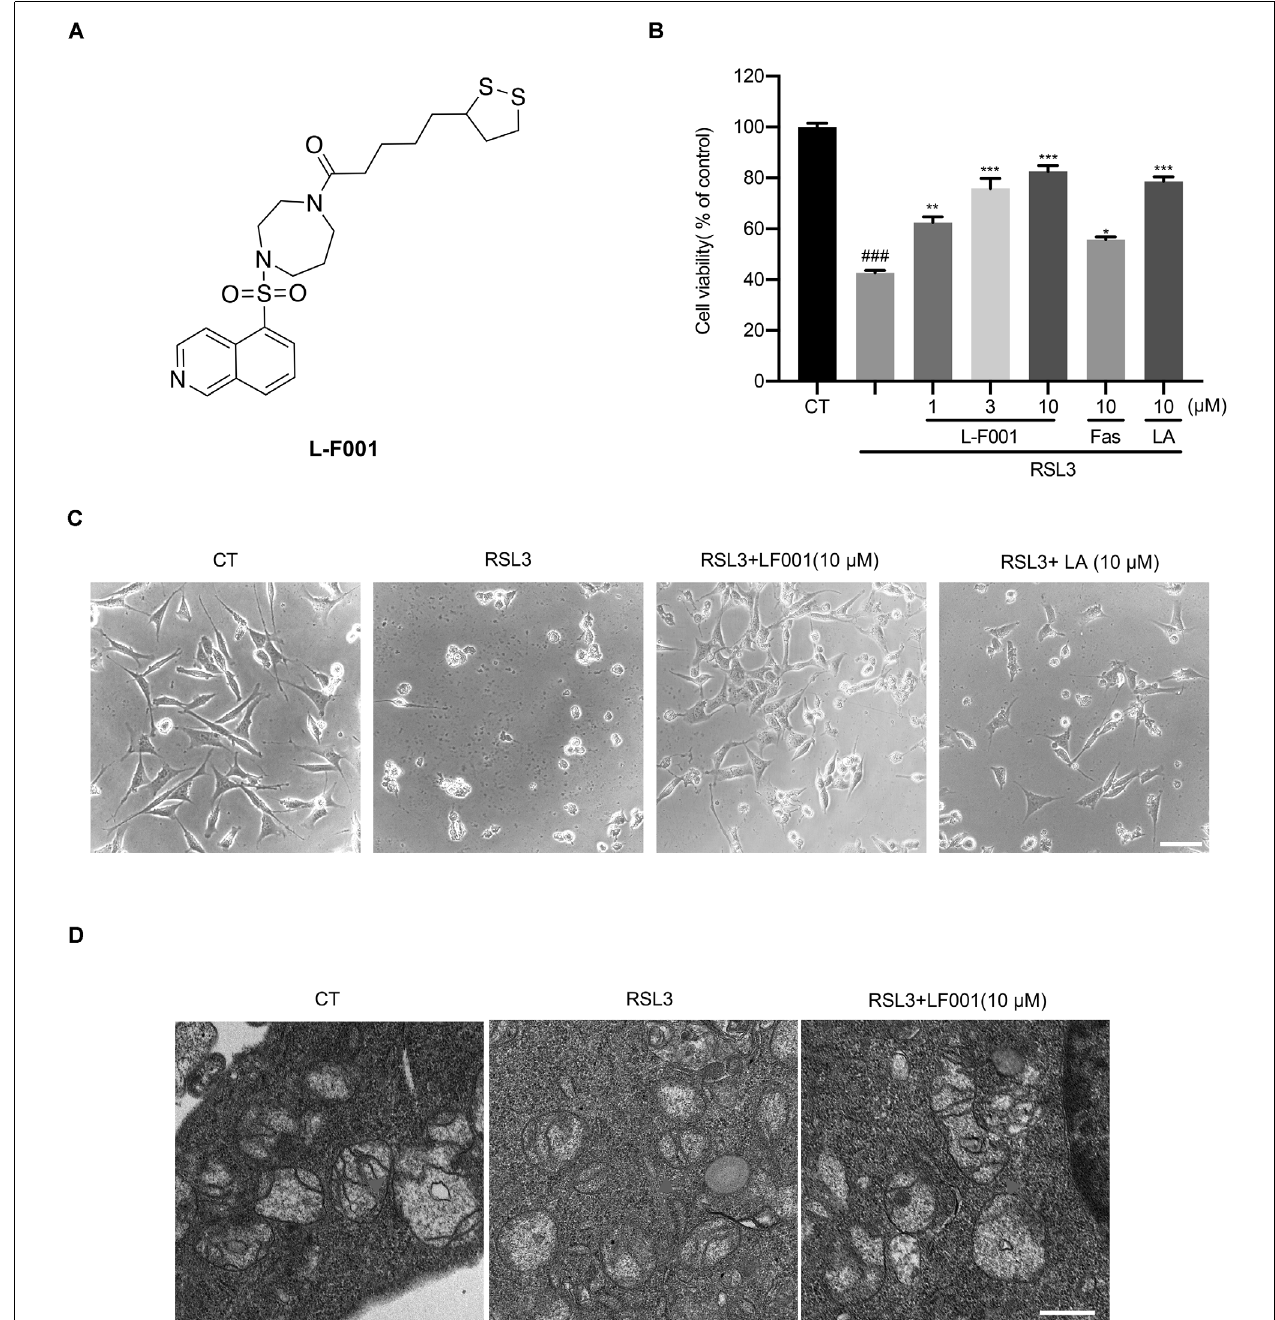
FIGURE 1 | L-F001 reduces RSL3-induced cytotoxicity in HT22 cells. (A) Chemical structure of L-F001. (B) HT22 cells were treated with 0.1 µ M RSL3 alone, and then added L-F001 (1–10 µ M), fasudil (10 µ M), and LA (10 µ M) at 37 ◦ C for 24 h. MTT assays were used to determine cell viability ( n = 5). (C) The morphology of HT22 cells (scale bar = 25 µ m). (D) Transmission electron microscopy pictures of mitochondrial in cells from control, RSL3, and RSL3 + L-F001 group (Scale bar = 1,200 nm). ### P < 0.001 compared with the control group. * P < 0.05, ** P < 0.01, and *** P < 0.001 compared with the RSL3-induced group.